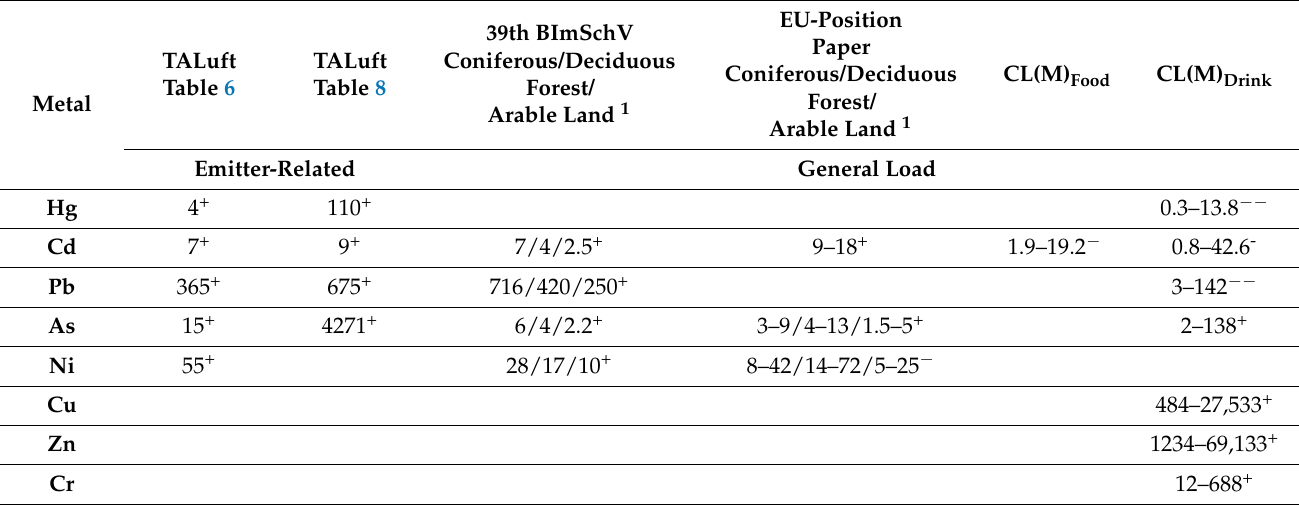
Table 16. Assessment values for heavy metal (in g ha − 1 a − 1 ) fluxes for the protection of human health and their ex- ceedance/undercutting by atmospheric deposition (for Hg: EMEP in 2013 [10,11]; for all others German dataset in 2010 from Schaap et al.